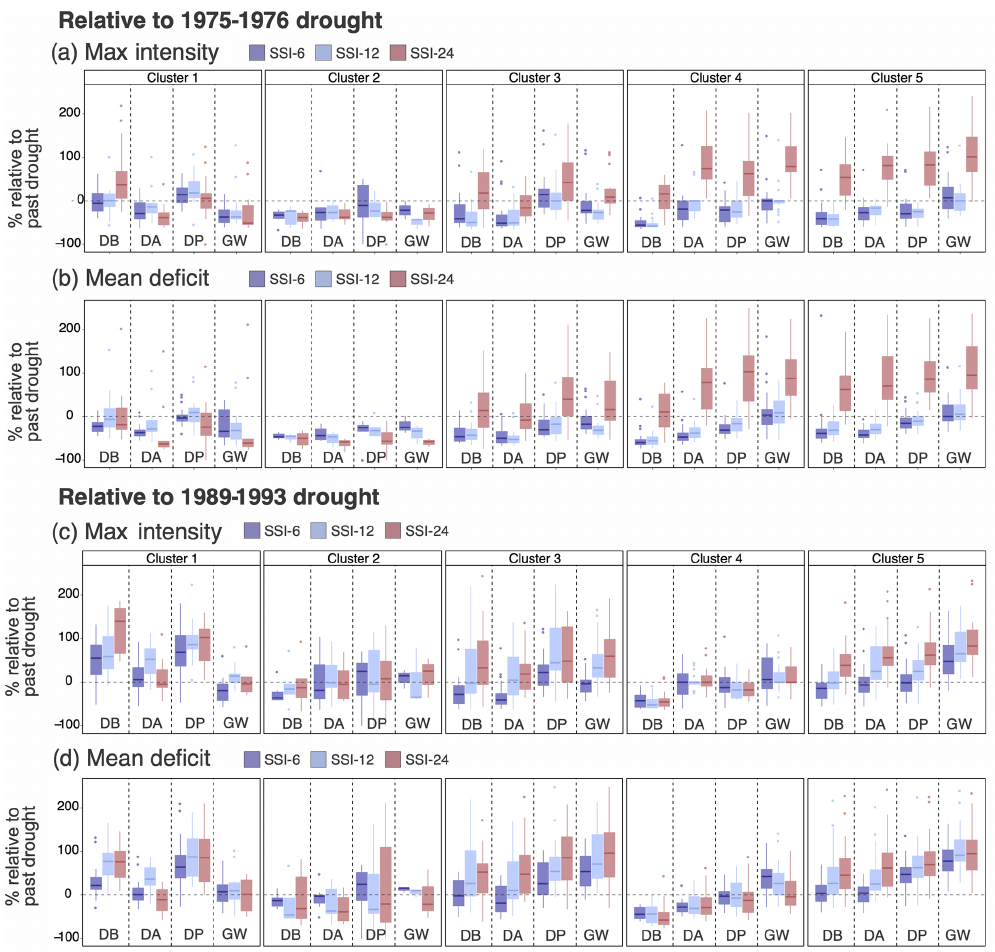
Figure 12. Percentage difference in max intensity (a, c) and mean deficit (b, d) calculated from SSI-6, SSI-12, and SSI-24 of the selected storylines relative to the 1976–1976 drought (top) and the 1989–1993 drought (bottom). Drought characteristics of the past droughts are calculated from simulated river flow, using the same input data for the baseline simulation as detailed in Sect.